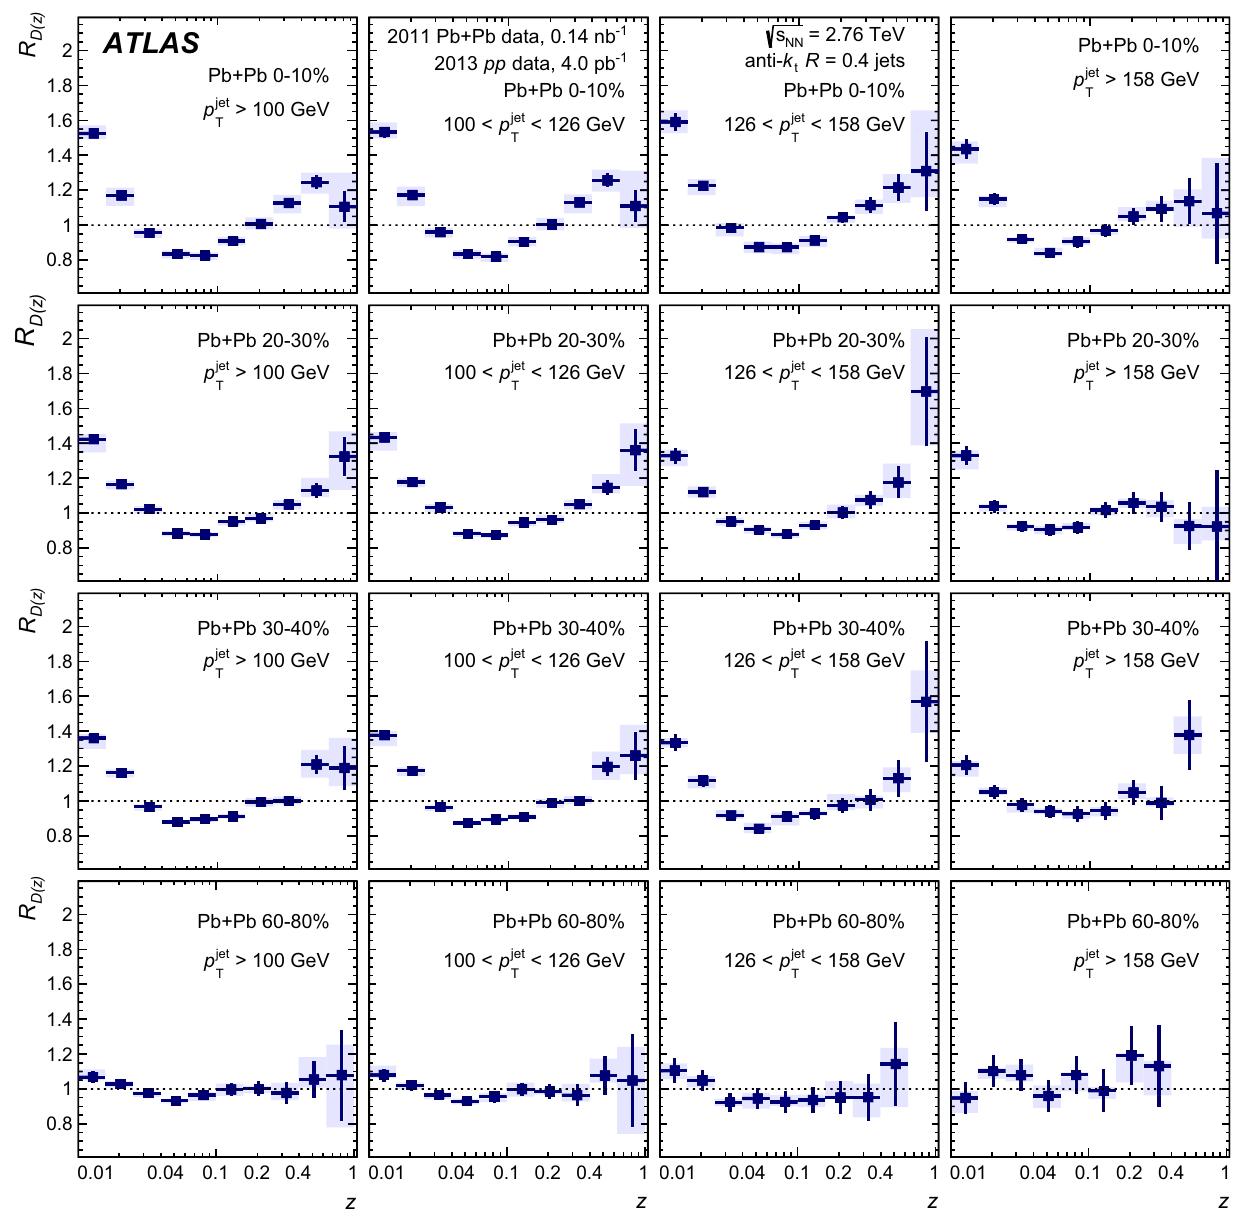
Fig. 7 The ratio R D ( z ) of unfolded D ( z ) distributions measured in heavy-ion collisions to unfolded D ( z ) distributions measured in pp col- lisions. The R D ( z ) distributions were evaluated in four different central-